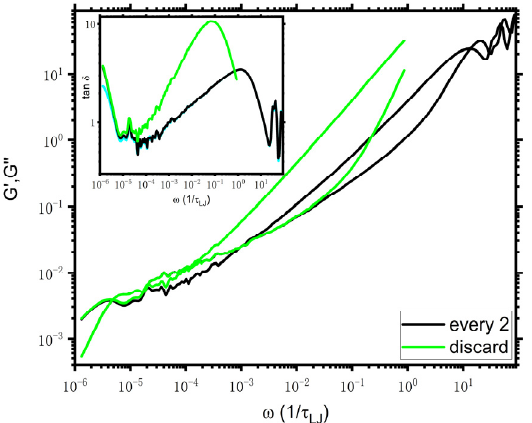
Figure 5. Viscoelastic moduli of KG model. The absolute values of 𝐺(𝑡) are input into i-Rheo GT, and the value of 𝐺(0) is 67.7. The inset presents the tan 𝛿 vs. frequency. The legends of “every 2” and “discard” mean that the stress is calculated using every second point, and the data of 𝐺(𝑡 < 1.2) of “every 2” are discarded, respectively.